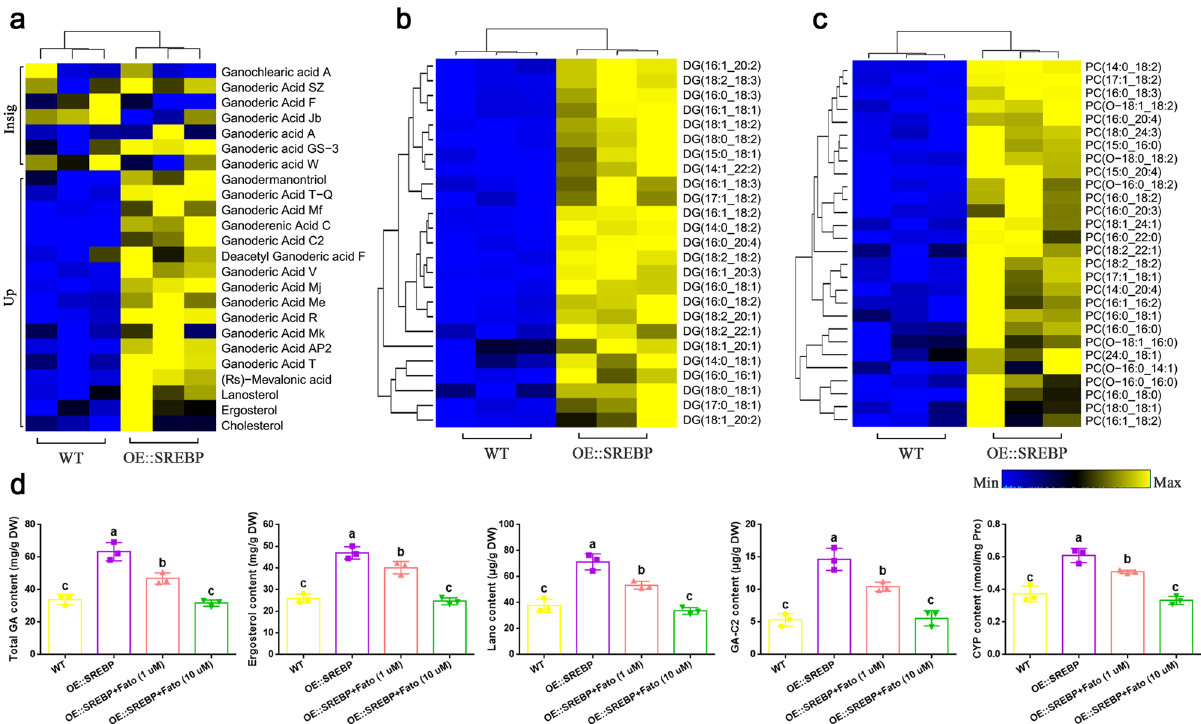
Fig. 5 The roles of SREBP in metabolic abundance of GAs, sterols, and lipids. a Heatmap showing the changes in the contents of detected GAs and sterols in WT and OE::SREBP strains. Up and Insig were indicated the signi fi cantly upregulated and no signi fi cantly differential metabolites, respectively, in the OE::SREBP strain compared to WT strain. Representative glycerolipids and glycerophospholipids, DG and PC, are shown in b and c , respectively. The signi fi cant differential metabolites had variable importance in projection (VIP) ≥ 1 and fold change ≥ 1.5 or ≤ 0.67. d The contents of cellular total GA, ergosterol, lanosterol (abbreviated as lano), GA-C2 and CYP in WT and OE::SREBP strains. 1 μ M and 10 μ M fatostatin were added at shaking for 5 days and then maintained until 7th days in liquid cultures of OE::SREBP strains. The values are the means ± SD of three independent experiments. Different letters indicate signi fi cant differences between the lines ( n = 3 independent experiments, P < 0.05, according to Duncan ’ s multiple range than that of WT strain. These results indicate that SREBP CYPs ( g4875 and g4164 ) were signi fi cantly upregulated in the positively regulates the expression of triterpenoid, ergosterol and OE::SREBP strain compared to the WT strain (Fig. 4d). lipid biosynthesis genes. To validate our transcriptomics data, 10 up-DEGs belonging to To further elucidate the role of SREBP in regulating triterpenoid, ergosterol and lipid biosynthesis, we performed targeted secondary metabolic pro fi ling and lipid metabolic the gene expression levels of 10 selected SREBP targets were pro fi ling between the WT and OE::SREBP strains. We signi fi cantly upregulated, ranging from 3.9- to 22.6-fold in the identi fi ed 35 differential secondary metabolites including 29 OE::SREBP strain (Fig. 4e), which is consistent with the RNA-seq upregulated, and 251 differential lipid metabolites, including results. Fatostatin, a speci fi c inhibitor of SREBP, can impair the 244 upregulated (VIP ≥ 1, and fold change ≥ 1.5 or ≤ 0.67), in activation of SREBP 35,36 . To further validate the up-regulation role of SREBP in the 10 SREBP targets, fatostatin was added to the OE::SREBP strain compared to the WT strain (Supple- the fermentation medium of OE::SREBP strain for detecting mentary Data 9). In particular, we observed that the contents of mRNA expression levels. As illustrated in Fig. 4e, an signi fi cantly mevalonic acid, lanosterol, and 13 different GAs were decrease in gene expression levels of ten selected SREBP targets signi fi cantly upregulated in the OE::SREBP strain (Fig. 5a). were observed when the exogenous fatostatin was added in Signi fi cant accumulation of 25 diacylglycerol (DG) species and OE::SREBP strain. A 10 μ g/mL fatostatin treatment in OE::SREBP 28 phosphatidylcholine (PC) species was observed in the strain led to not signi fi cantly different in mRNA expression levels OE::SREBP strain (Fig. 5b and c).